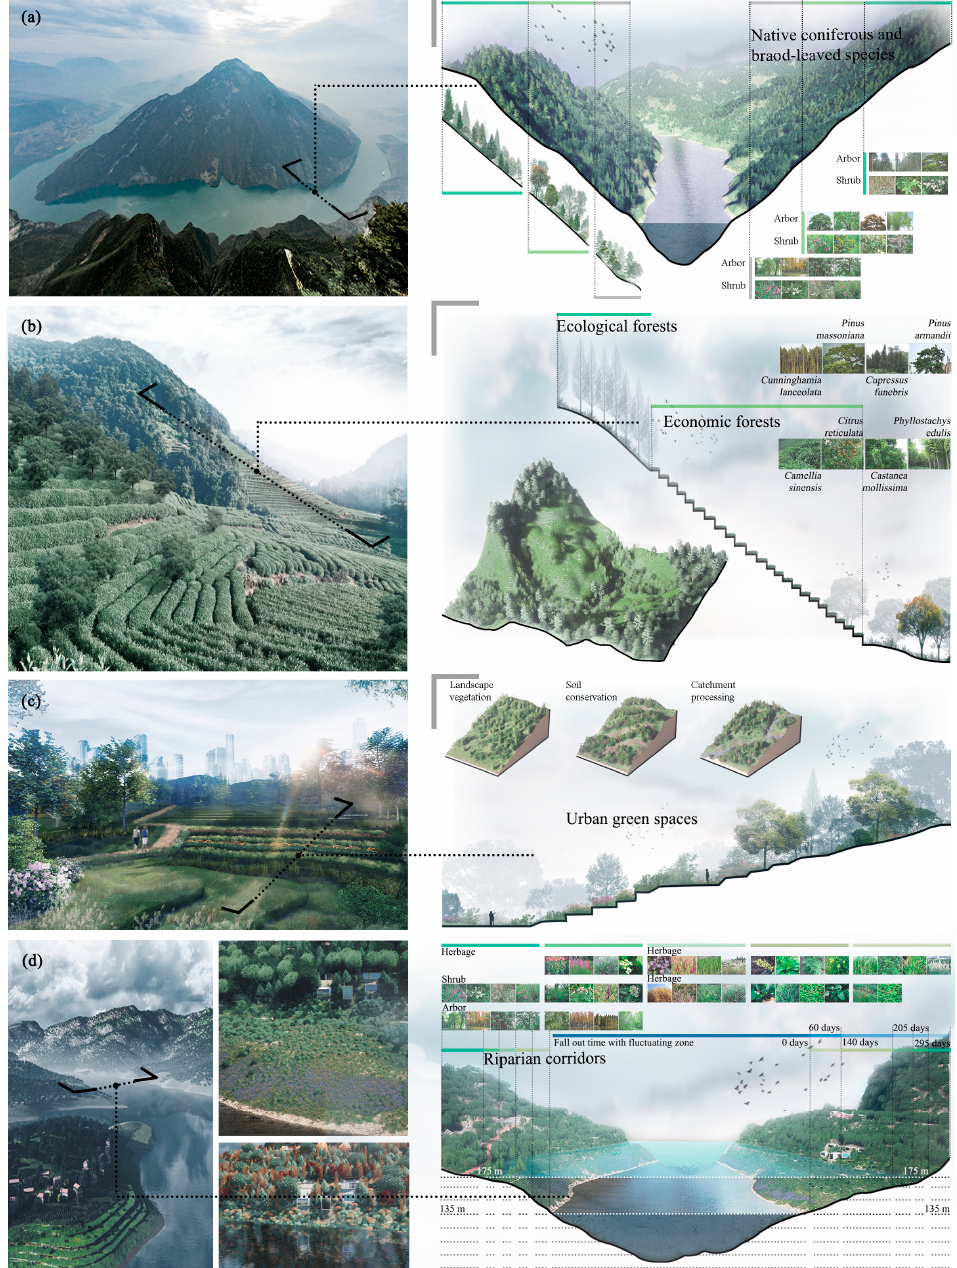
Figure 8. Green infrastructure planning and designing for ecological forest landscape ( a ); agroforestry landscape ( b ); urban green space ( c ) and riparian corridor ( d ) in the TGR area. Note: The left pictures illuminate the complex topographical characters and various landscapes, while the right pictures are our planning and designing sections of green infrastructure for these landscapes.